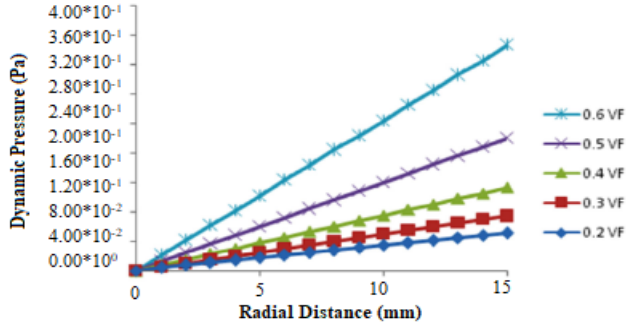
Figure 48. Impact of volume fraction in dynamic pressure